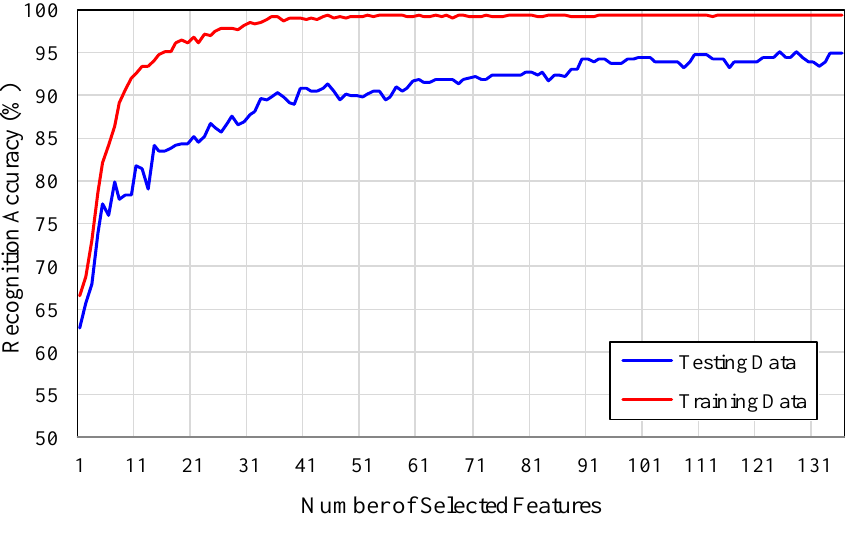
Figure 8. Recognition accuracy under different numbers of AdaBoost selected features.